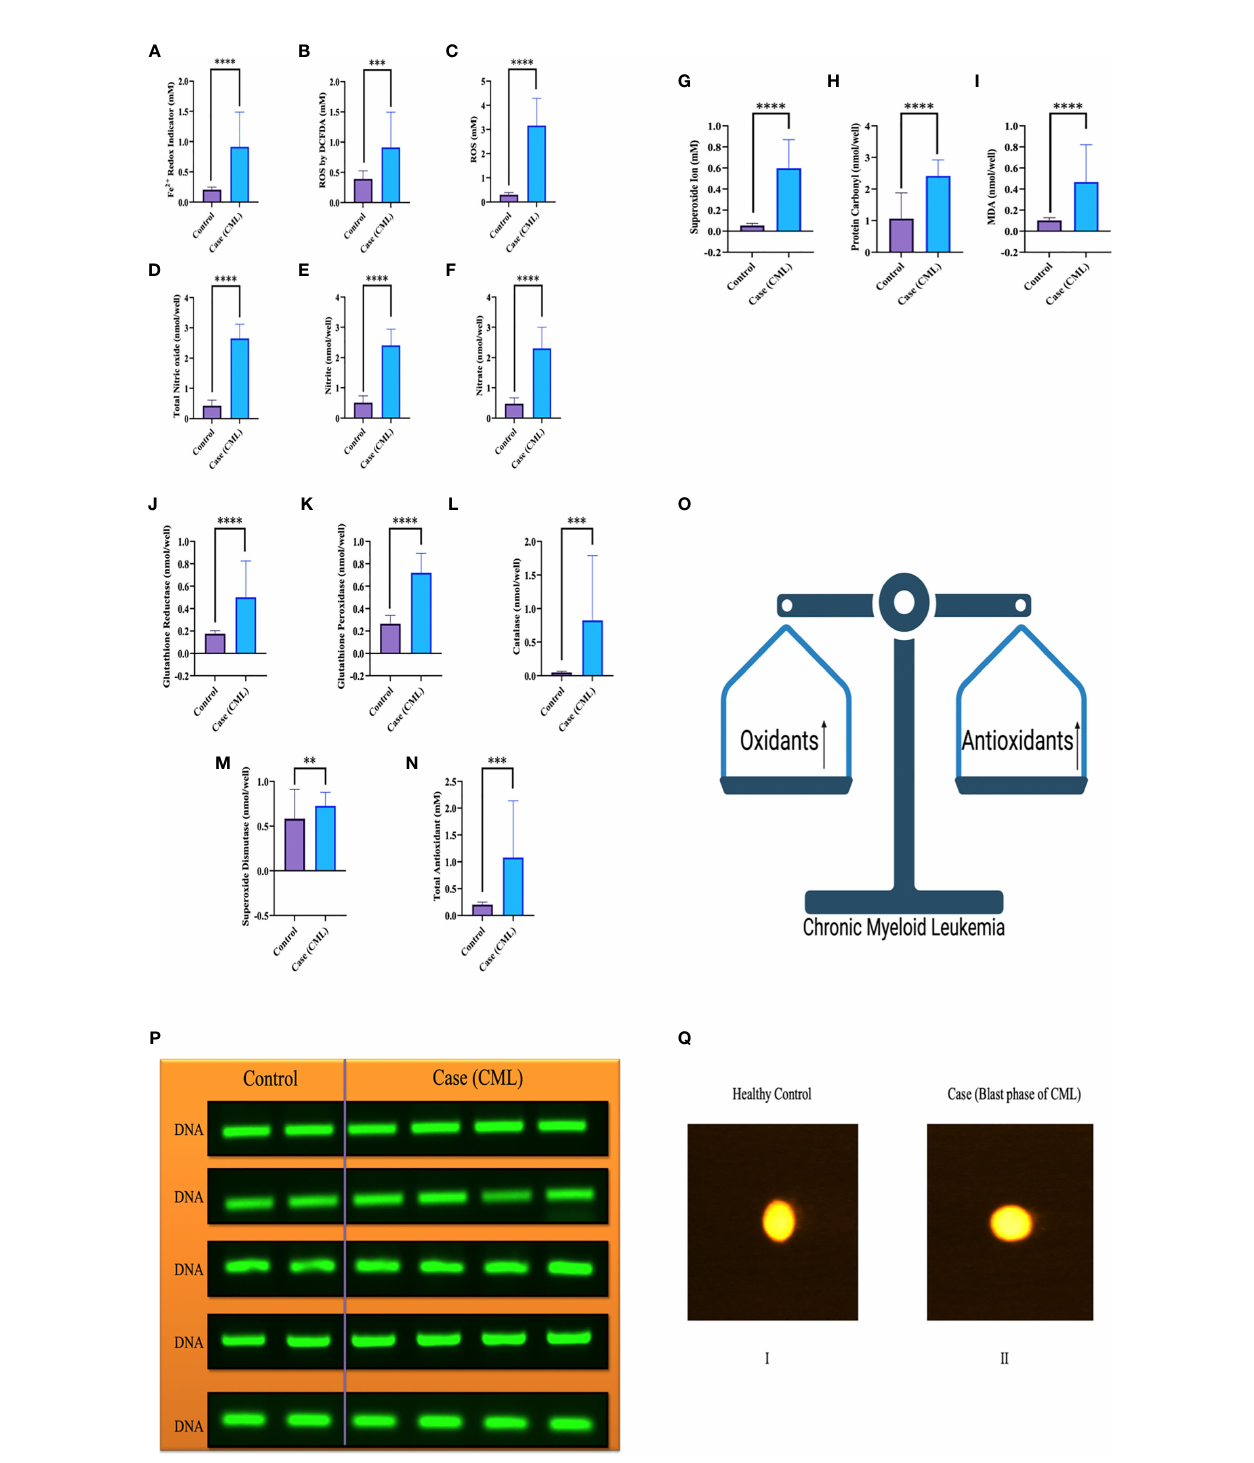
FIGURE 2 | Redox system in the pathogenesis of CML and DNA fragmentation. (A – I) Signi fi cant oxidative parameters and their overexpression were found in CML patients. (J – O) Antioxidant levels were also found to be high in CML due to their pathogenesis and protection from apoptosis. Both oxidative and antioxidative factors were found to be high and make an equilibrium for survival. (P, Q) shows that the integrity of DNA was maintained when both parameters were upregulated, which triggered morphological changes in CML cells but was not able to damage DNA integrity. All the data are the mean ± SD, ****p<0.00001, ***p<0.0001, **p<0.001; Student ’ s t test